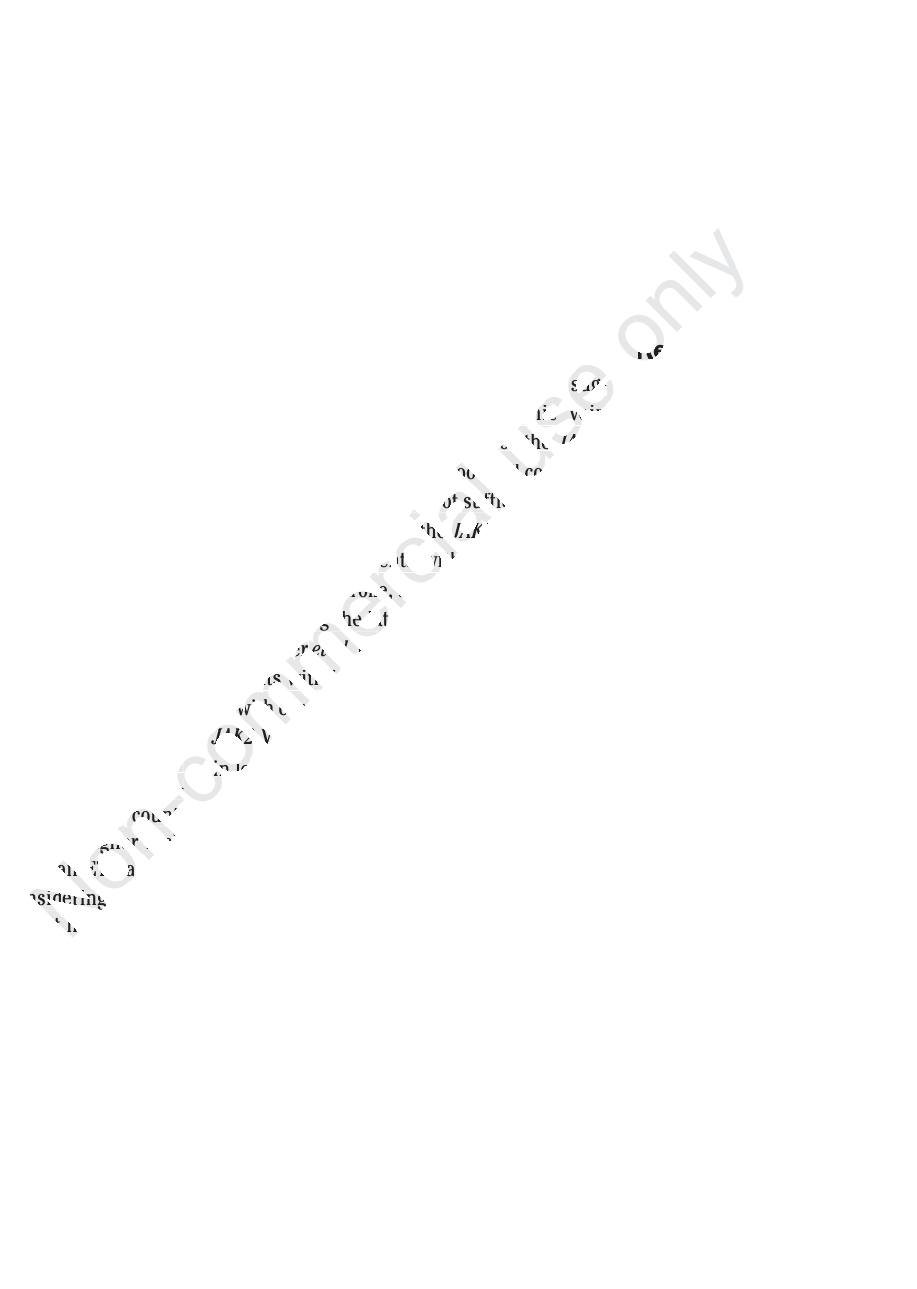
V617F irrespective of their blood cell count.